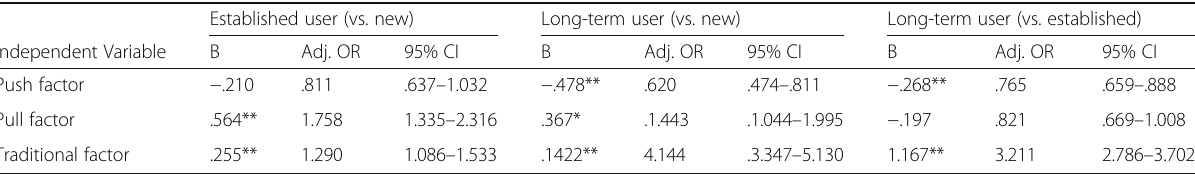
Table 5 Results of multinomial logistic regression analysis Established user (vs. new) Long-term user (vs.